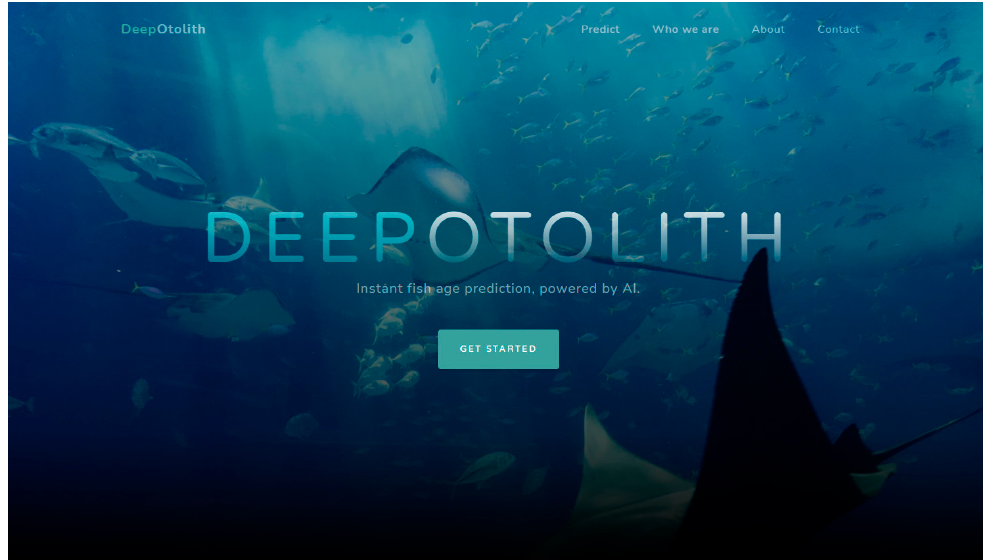
Figure 1. Landing page of the DeepOtolith platform (http://otoliths.ath.hcmr.gr/, accessed on 1 March 2022), which applies deep learning techniques to predict fish age from otolith images. Table 1. Fish species that are currently available on the DeepOtolith platform. Species